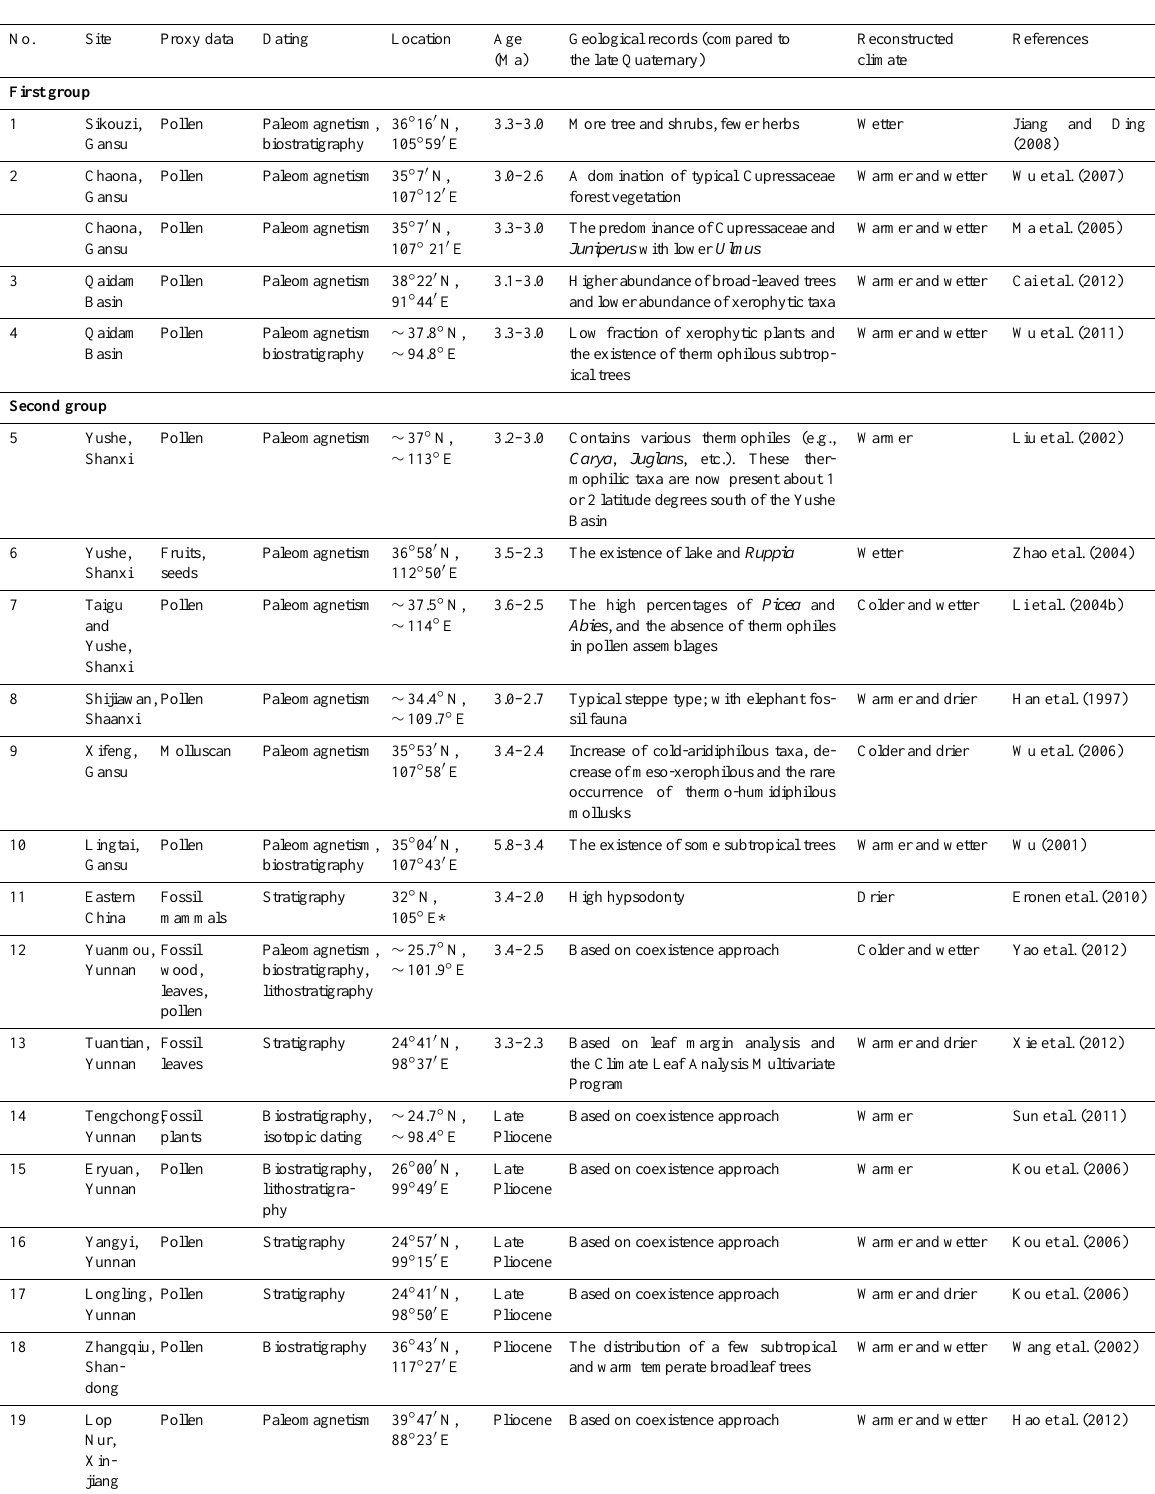
Table 2. Data used to reconstruct the mid-Pliocene climate in China.